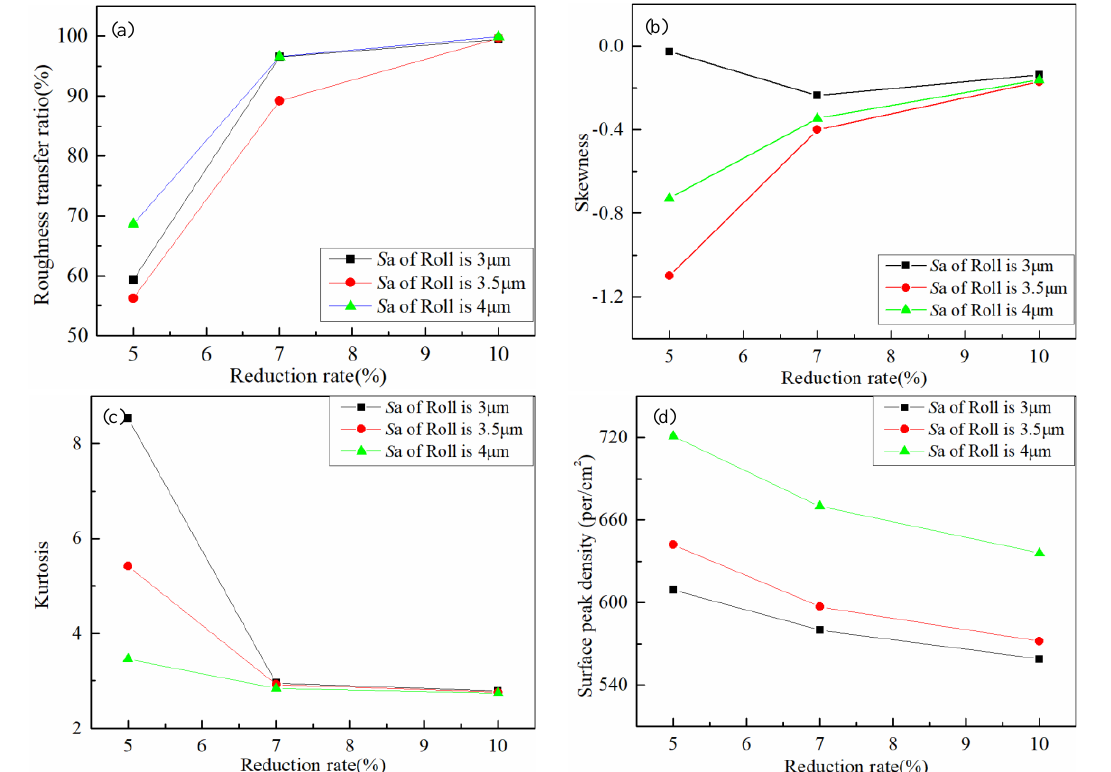
Figure 12. Strip surface parameters under different conditions: ( a ) roughness transfer ratio, ( b ) Figure12. Stripsurfaceparametersunderdi ff erentconditions: ( a )roughnesstransferratio, ( b )skewness, skewness, (c) kurtosis and ( d ) surface peak density. ( c ) kurtosis and ( d ) surface peak